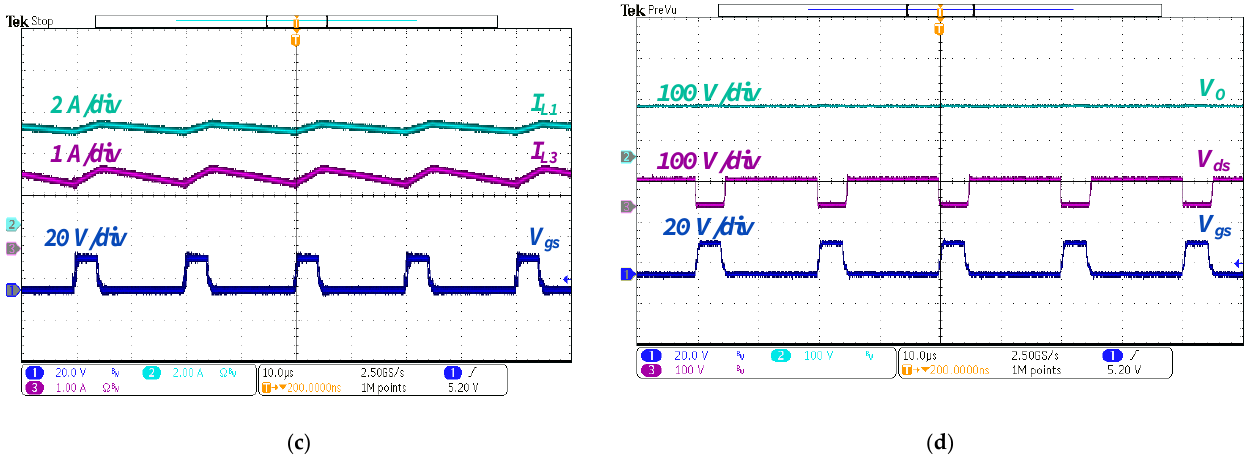
Figure 20. Related waveforms of the experimental results for proposed converter III. ( a ) Gating pulse, input voltage, and output voltage; ( b ) gating pulse, voltage for capacitors C 1 , C 2 , and C 3 ; ( c ) gating pulse, inductor current for L 1 and L 3 ; and ( d ) gating pulse, switch voltage and output voltage.